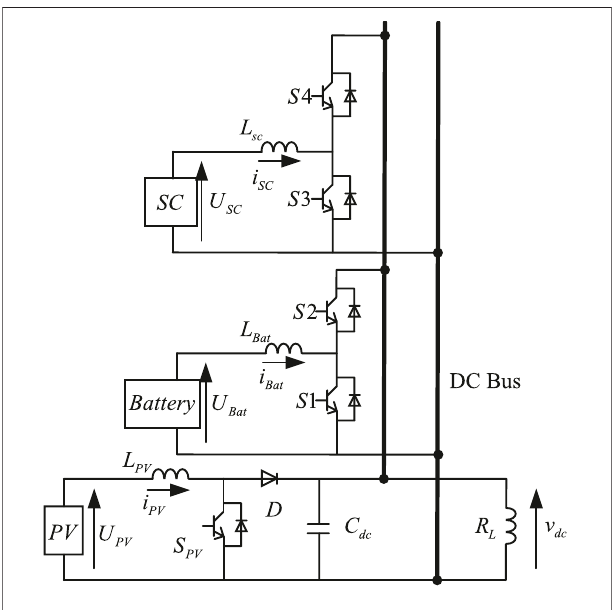
FIGURE 2 | DC microgrid structure.